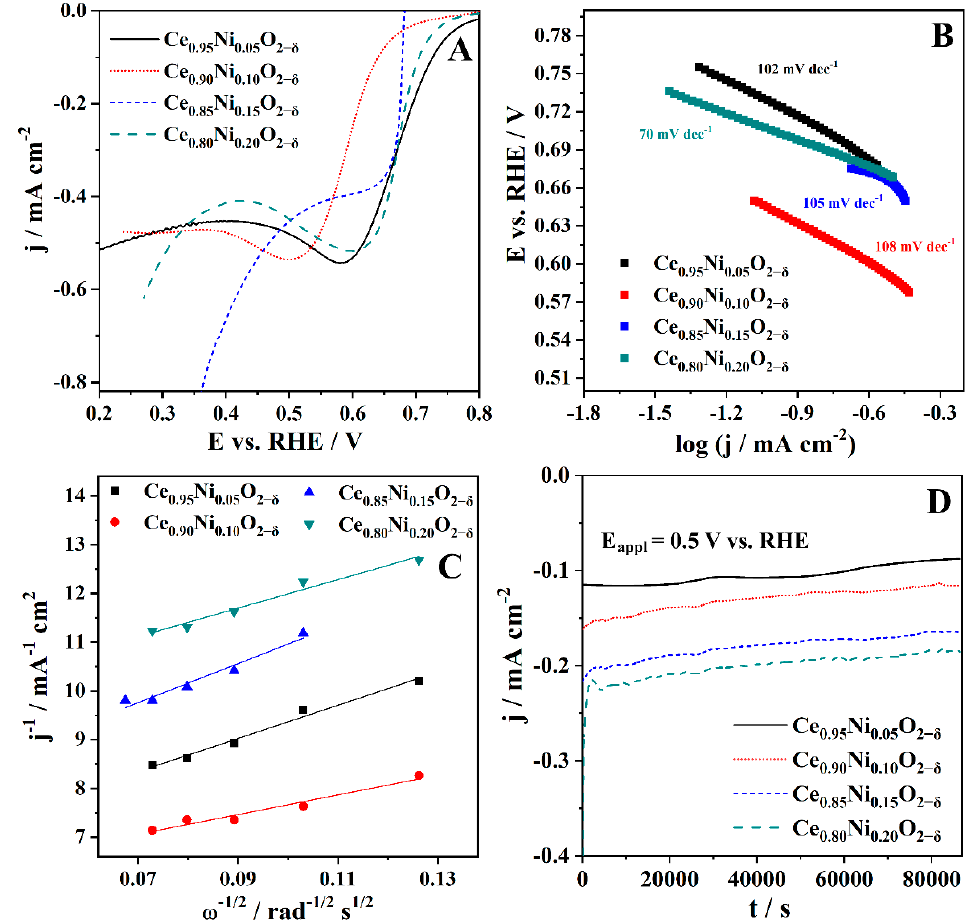
Figure 2. ( A ) CVs (cathodic scan) of the four studied materials recorded at a scan rate of 50 mV s − 1 with the corresponding ( B ) Tafel slopes, ( C ) Koutecky–Levich plots, and ( D ) CA curves recorded for 24 h. All measurements performed in O 2 -saturated 0.1 M KOH. Potential values are corrected for the ohmic drop in the electrolyte.